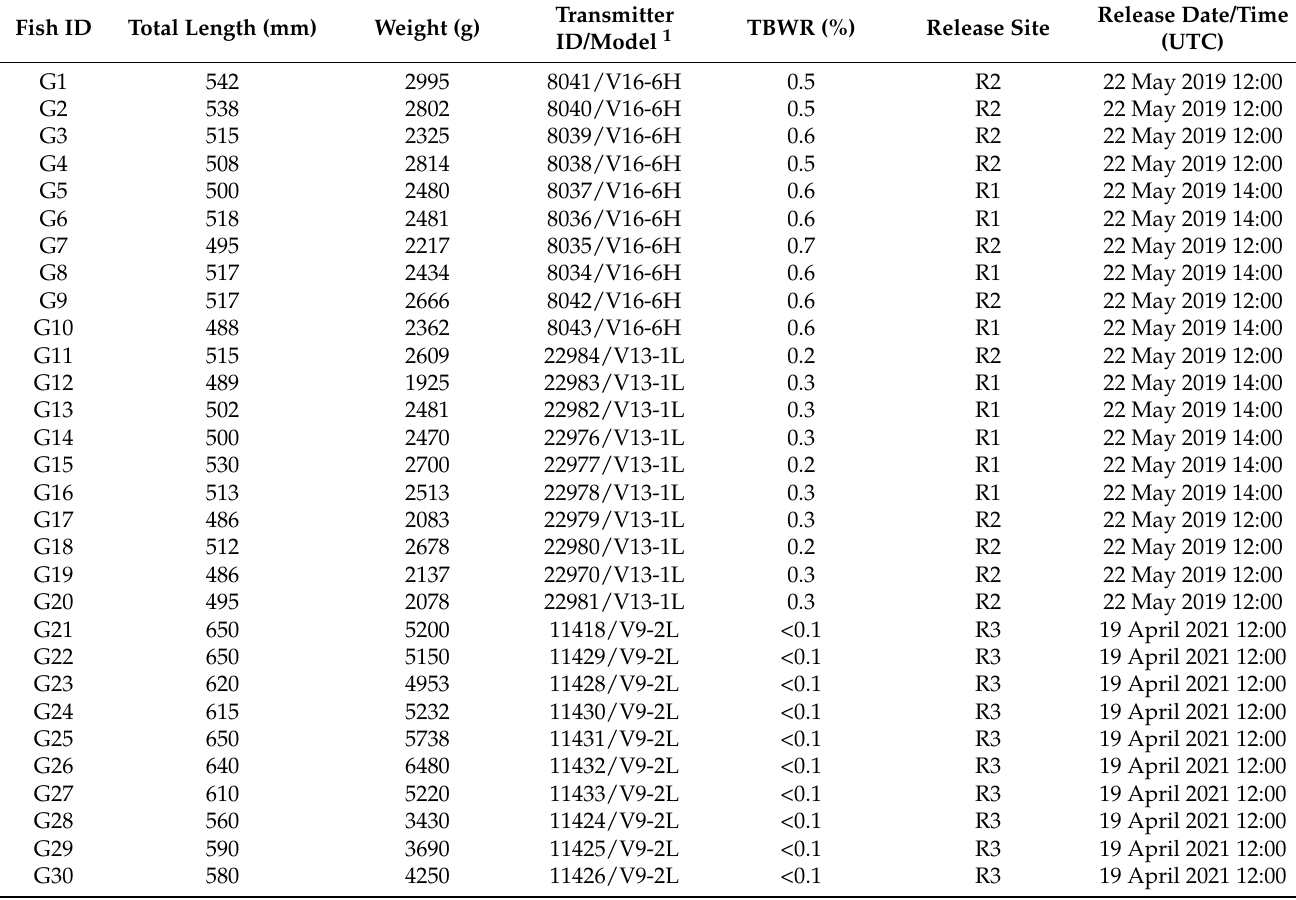
Table 1. Summary data of the tagged and tracked dusky